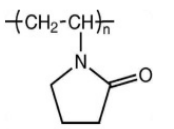
with evaporation (PET-4) had the highest HA rejection of up to